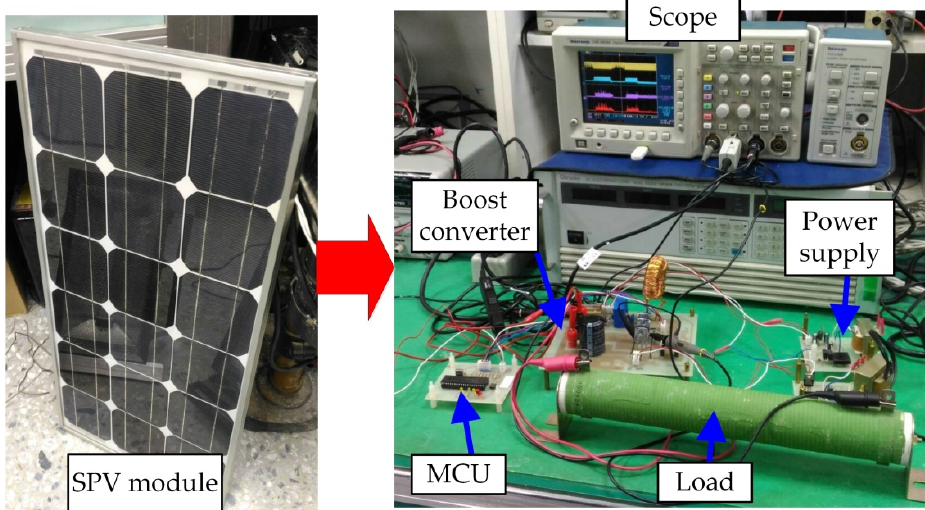
Figure 7. The experimental SPV module and the prototype setup.